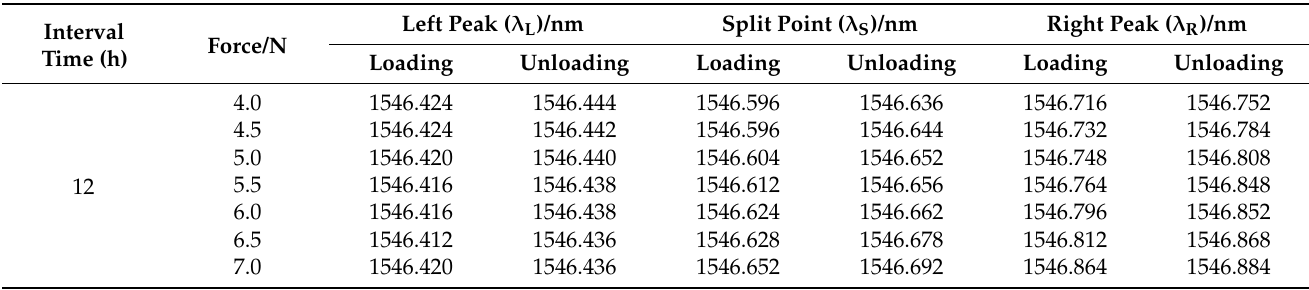
Table 2. Experimental results of local lateral forces and left peak, split point, and right peak wave- lengths for the FBG under different time